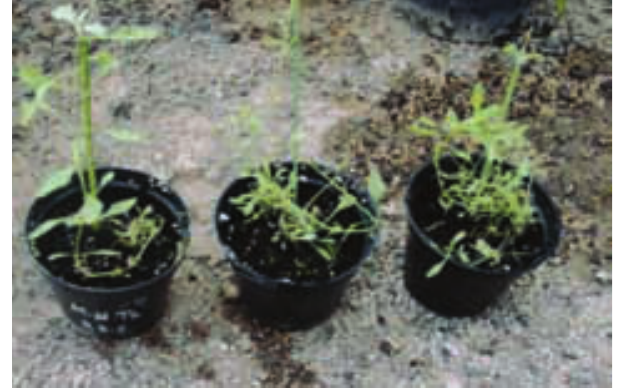
Fig. 5. In vitro propagated acclimatized Atriplex halimus (2-3 months old) grown in the green house